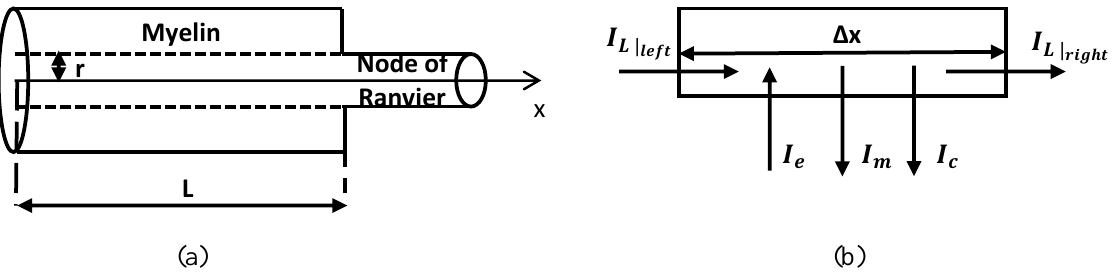
Figure 3. (a) Schematic of a part of a neuron made of an internodal (myelinated) region of length 𝑳 and a node of Ranvier. The radius of the neuron is denoted by 𝒓 . (b) The electric currents entering (the longitudinal current 𝑰 𝑳|𝒍𝒆𝒇𝒕 and external current 𝑰 𝒆 ) and exiting ( the longitudinal current 𝑰 𝑳|𝒓𝒊𝒈𝒉𝒕 , the membrane current 𝑰 𝒎 , and the capacitor current 𝑰 𝒄 ) a neuronal segment of length 𝚫𝒙